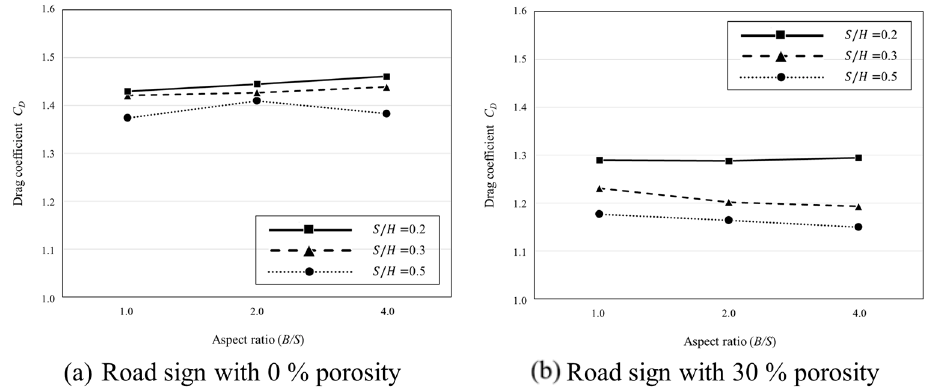
Figure 3. Drag coefficient of perforated road sign with 0% and 30% porosity.